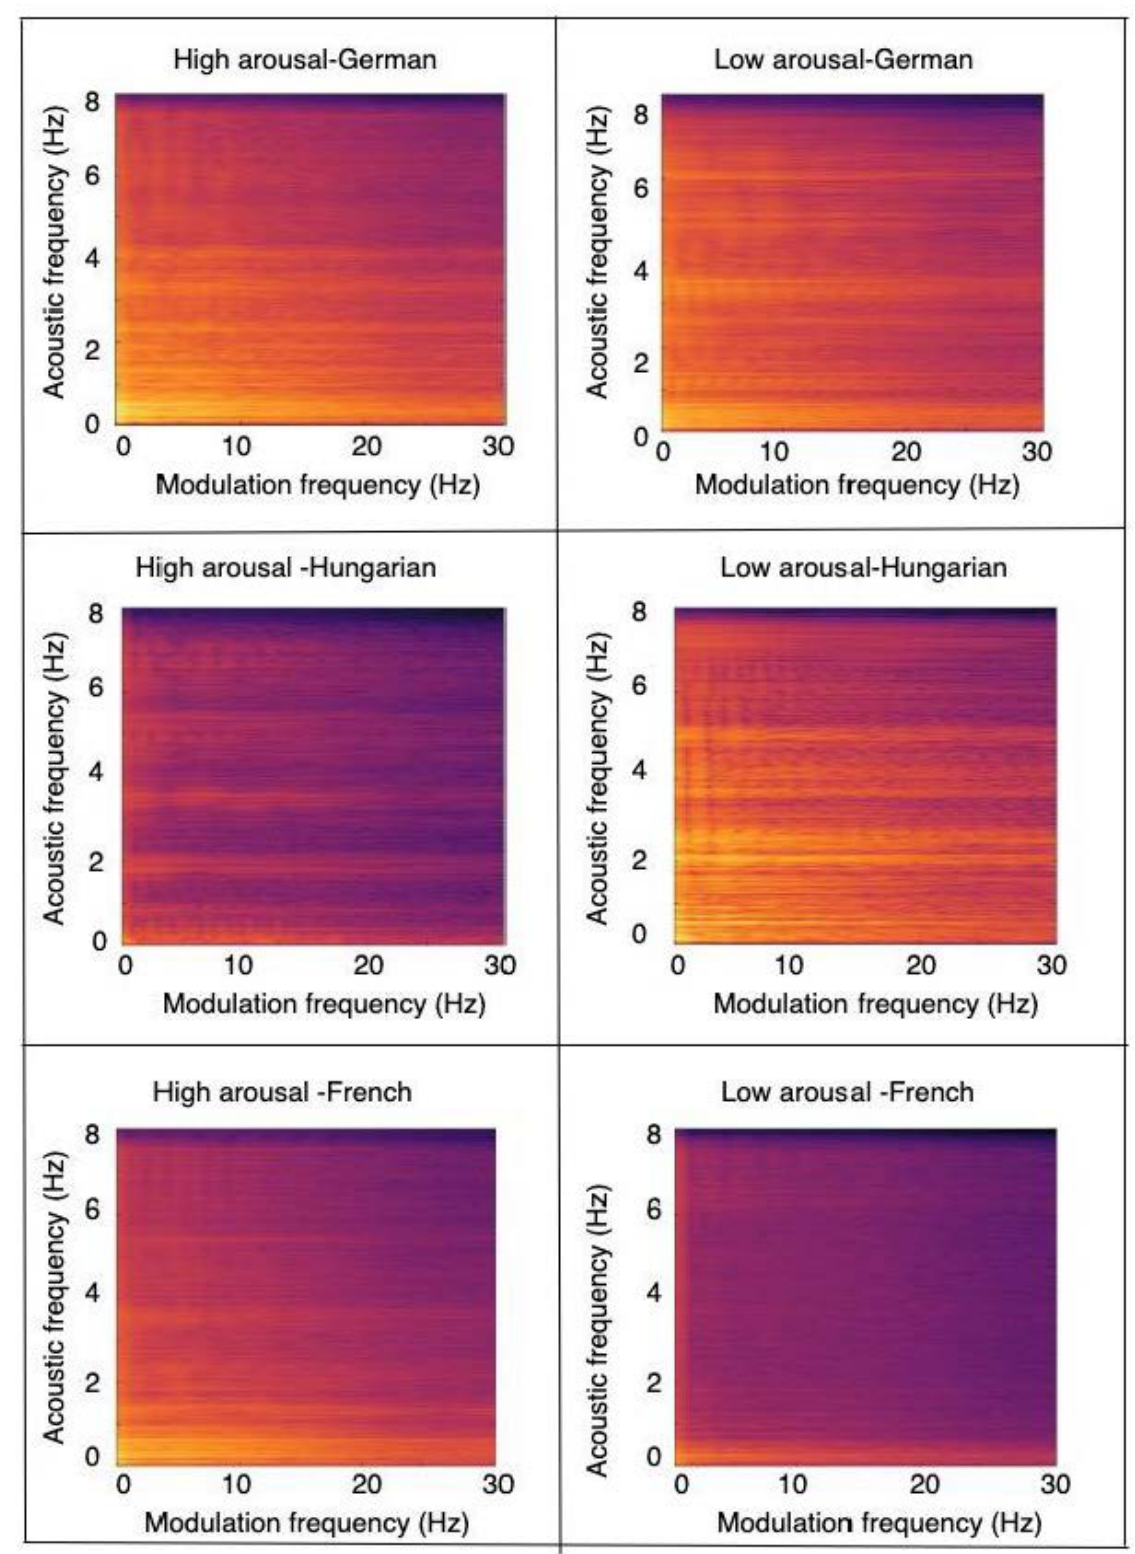
Figure 5. Average modulation spectrogram for German (top), Hungarian (middle), and French (bottom) language for high- (left) and low- (right) arousal